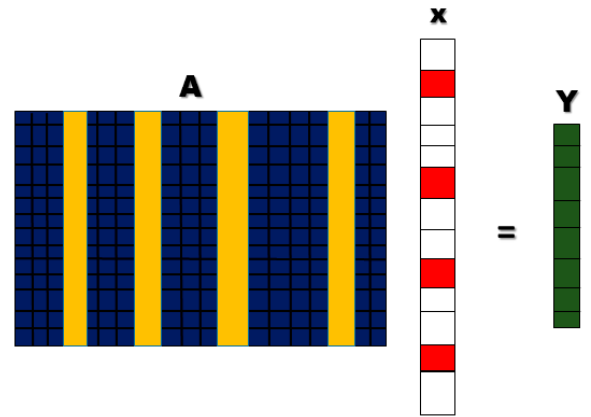
Figure 6. Sparse representation model. The dictionary is represented as A = [ a 1 , · · · , a k ], dictionary atom is represented as a i , x is a sparse coefficient vector and Y is the output signal result as combination of A × x .